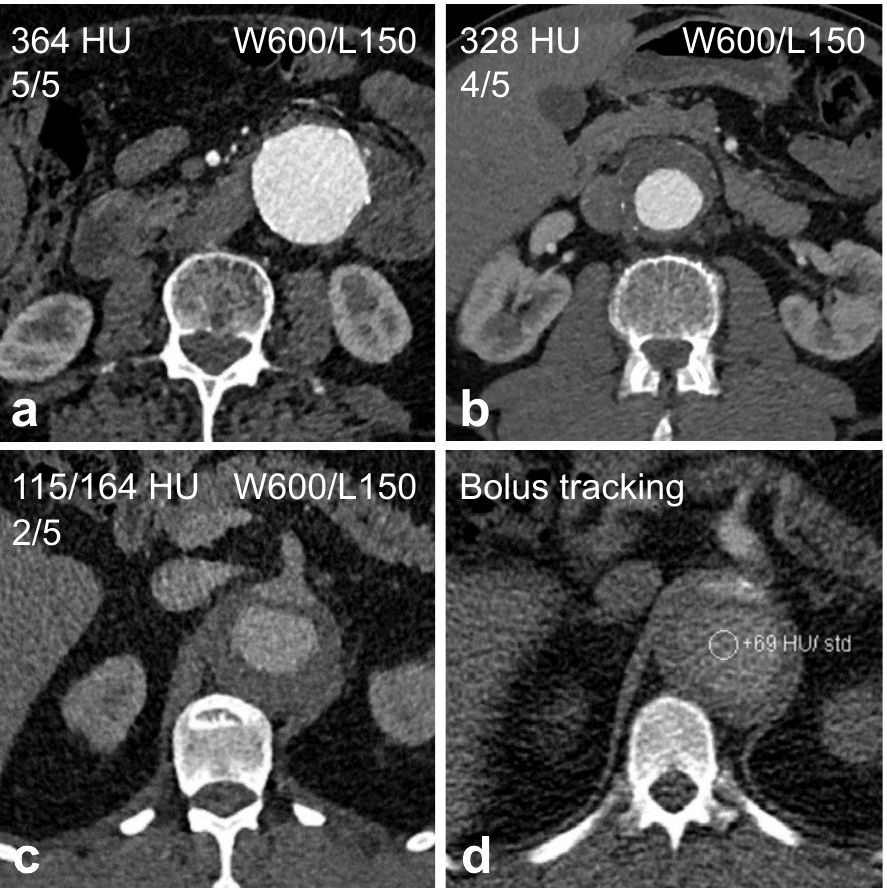
Figure 2. Representative examples for the low-dose CTA with identical window/level (W/L) settings. ( a ) CTA rated as excellent image quality. ( b ) CTA rated as good image quality. ( c ) CTA rated as fair image quality. ( d ) Bolus tracking of the same patient as in c showing the monitoring ROI placed in the false lumen of the aortic dissection.